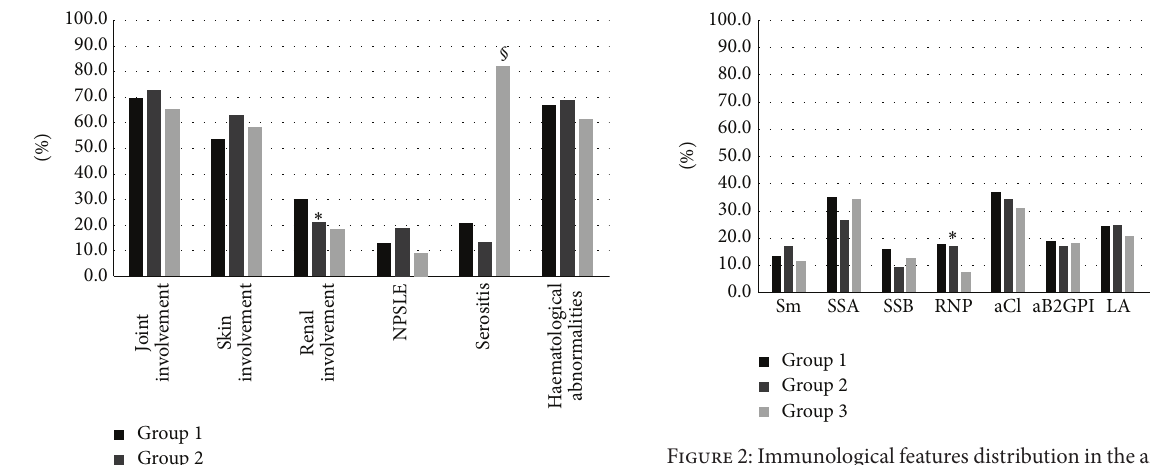
Figure 2: Immunological features distribution in the anti-dsDNA + (group 1), anti-dsDNA ± (group 2), and 96 (24.4%) anti-dsDNA − (group 3) SLE patients. ∗ 𝑃 = 0.04 group 1 versus group 3 and group 2 versus group 3; § 𝑃 = 0.005 group 1 versus group 3 and group 2 versus group